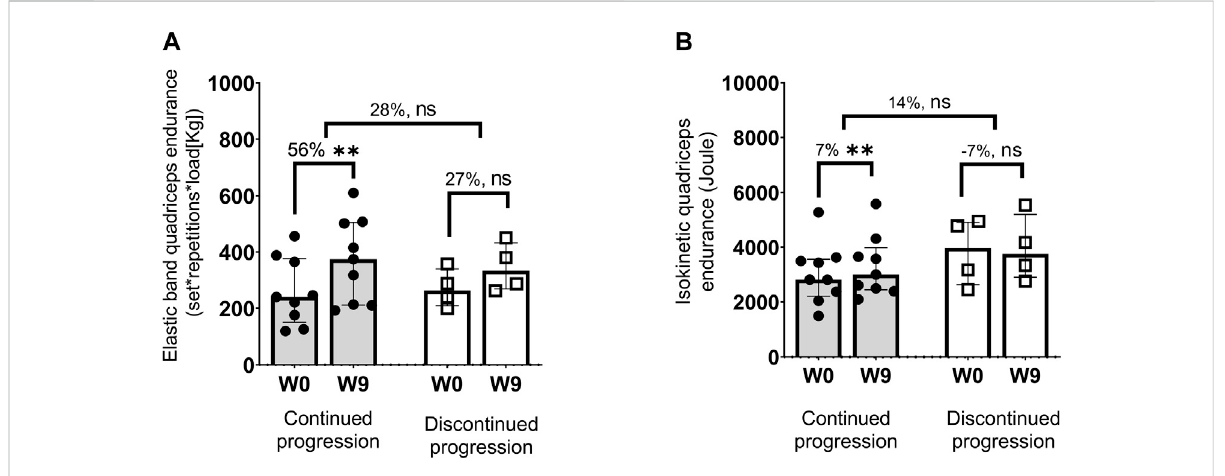
FIGURE 6 Values are Median (interquartile, 25 – 75 range). W = Week. Increase in elastic (set * repetition * load) (A) and isokinetic total work from 30 maximal isokinetic knee extensions performed at an angular velocity of 90 ° /second) (B) . * p < 0.05, ** p <